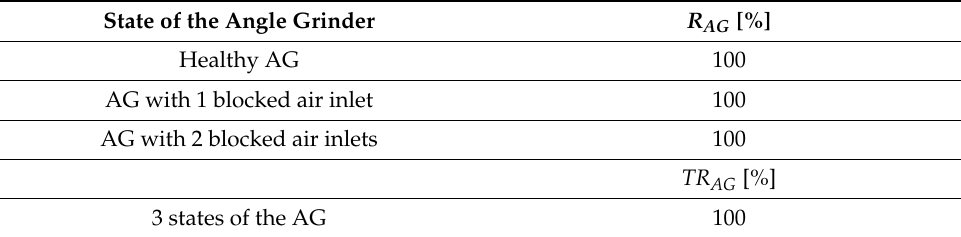
Table 1. Values of TR AG and R AG for using of BCAoMID − F, the sum of pixels, and NN classifier. State of the Angle